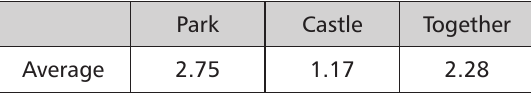
How visitors evaluate the arboretum’s